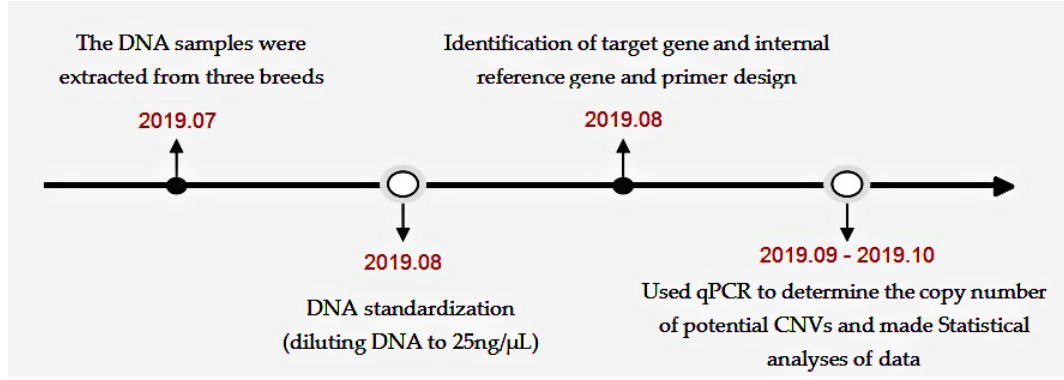
Figure 1. The overall flow diagram of the experiment.